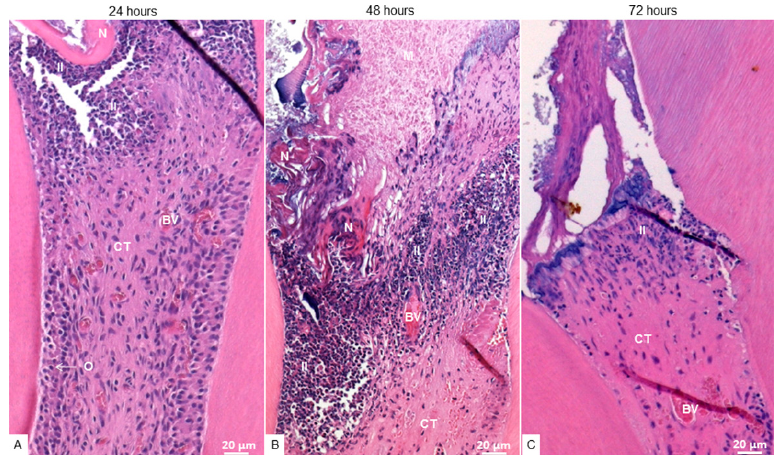
Figure 1- Photomicrographs of hematoxylin and eosin-stained cervical radicular third of MTA-treated teeth. A: At 24 hours, presence of inflammatory infiltrate (II) below the capping material (M), normal connective tissue (CT) with blood vessels (BV) in the central area and odontoblasts (O) in the periphery of the pulp tissue; B: At 48 hours, presence of II predominantly located close to the M and superficial necrosis (N); C: At 72 hours, presence of II in the cervical third and normal CT. 20x